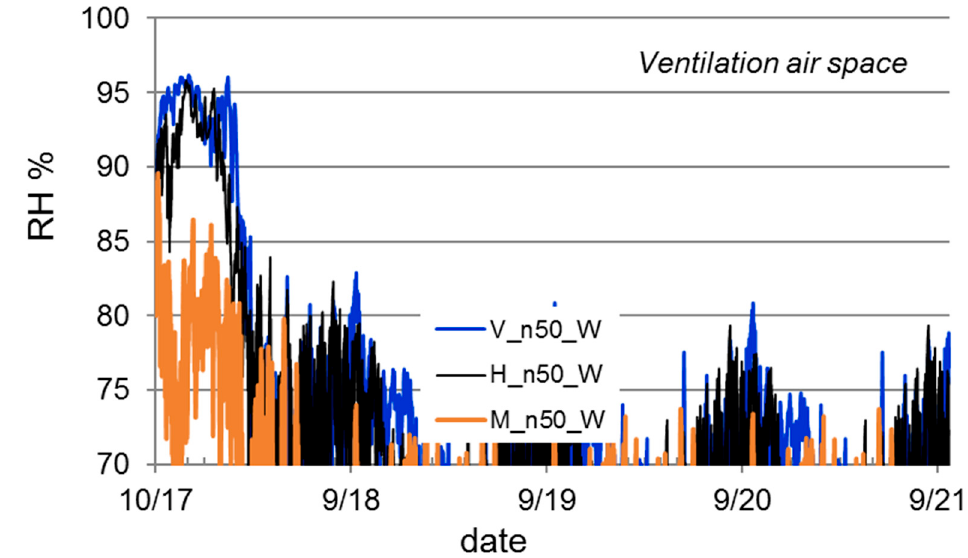
Figure 22. Brick wall, wet exterior core, ventilation scheme 2, n = 50 1 / h. The relative humidity in the ventilation air space in the boundary between mineral wool back layer insulation and the PU-insulation of the panel in three di ff erent climates during the four-year simulation